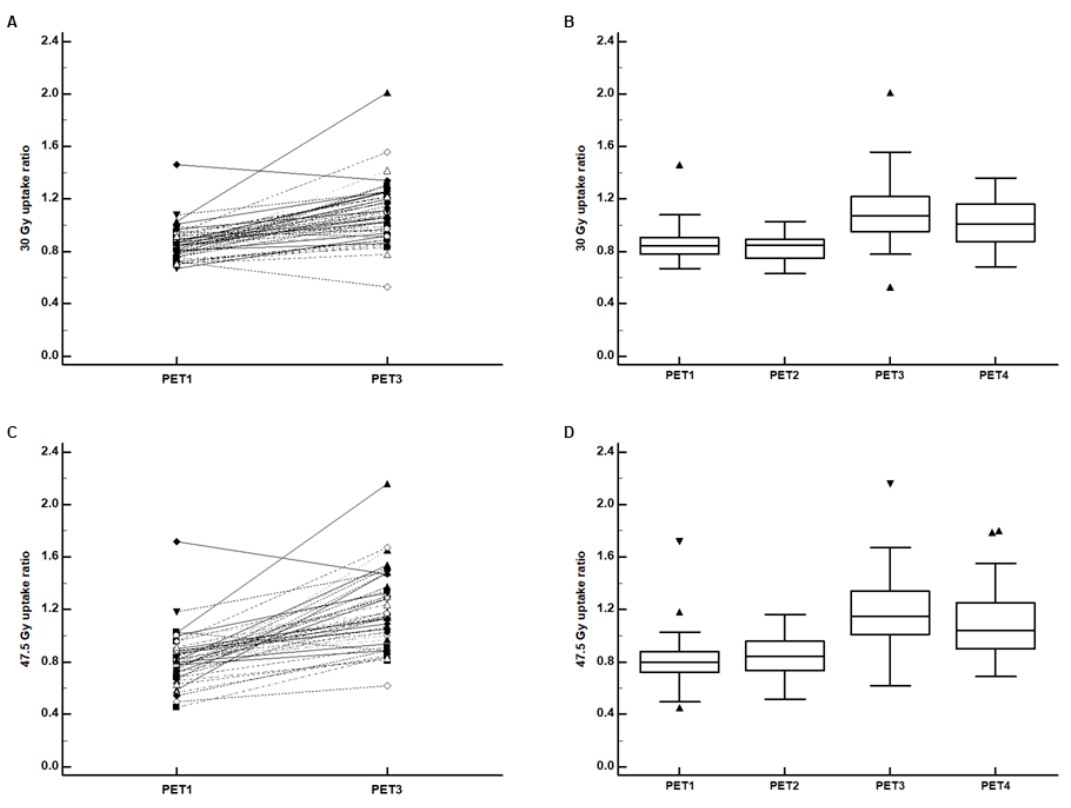
Figure 4. ( A ) Pairwise comparison of the 30 Gy-irradiated myocardium-to-low-irradiated myocardium F-18 Fluorodeoxyglucose (FDG) uptake ratio (30 Gy uptake ratio) between positron emission tomography / computed tomography (PET / CT) for staging work-up (PET1) and PET / CT after the completion of the adjuvant radiotherapy (PET3) and ( B ) distributions of the 30 Gy uptake ratio on PET1 ( n = 55), PET / CT after the completion of the adjuvant chemotherapy (PET2) ( n = 29), PET3 ( n = 55), and follow-up PET / CT for surveillance (PET4) ( n = 37). ( C ) Pairwise comparison of the 47.5 Gy-irradiated myocardium-to-low-irradiated myocardium FDG uptake ratio (47.5 Gy uptake ratio) between PET1 and PET3 and ( D ) distributions of the 47.5 Gy uptake ratio on PET1 ( n = 47), PET2 ( n = 24), PET3 ( n = 47), and PET4 ( n = 30). (Central box, the values from the 25 percentile to 75 percentile; middle line in the box, median value; error bar, extending from the minimum value to the maximum value except outside values; marker, an outside value which is smaller than 25 percentile minus 1.5 times the interquartile range or larger than the 75 percentile value plus 1.5 times the interquartile range).